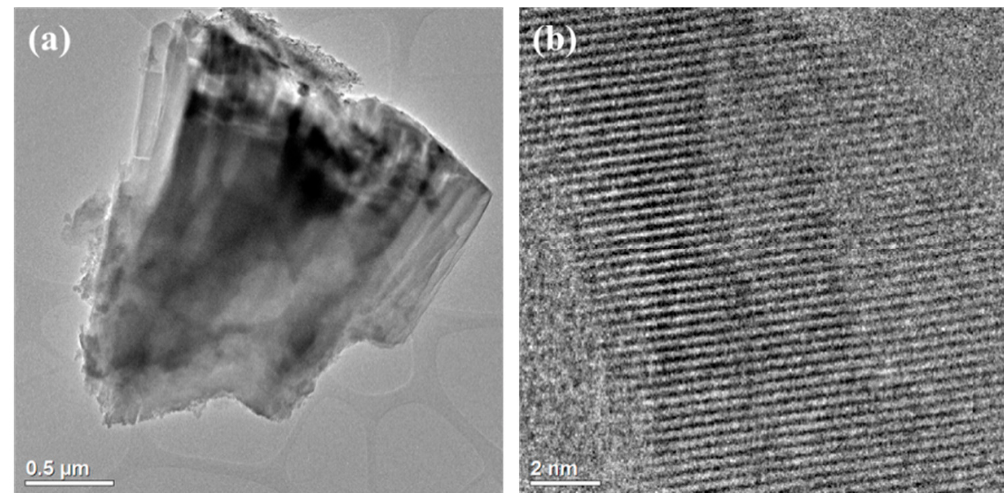
Figure 5. HR/TEM images of Na-P1: whole crystal ( a ), cross-section with channels ( b ).